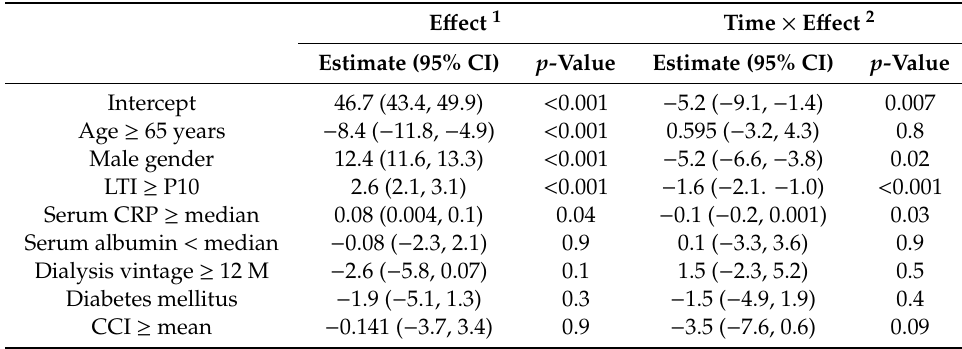
Table 4. Multivariate model for relation of covariates and lean tissue